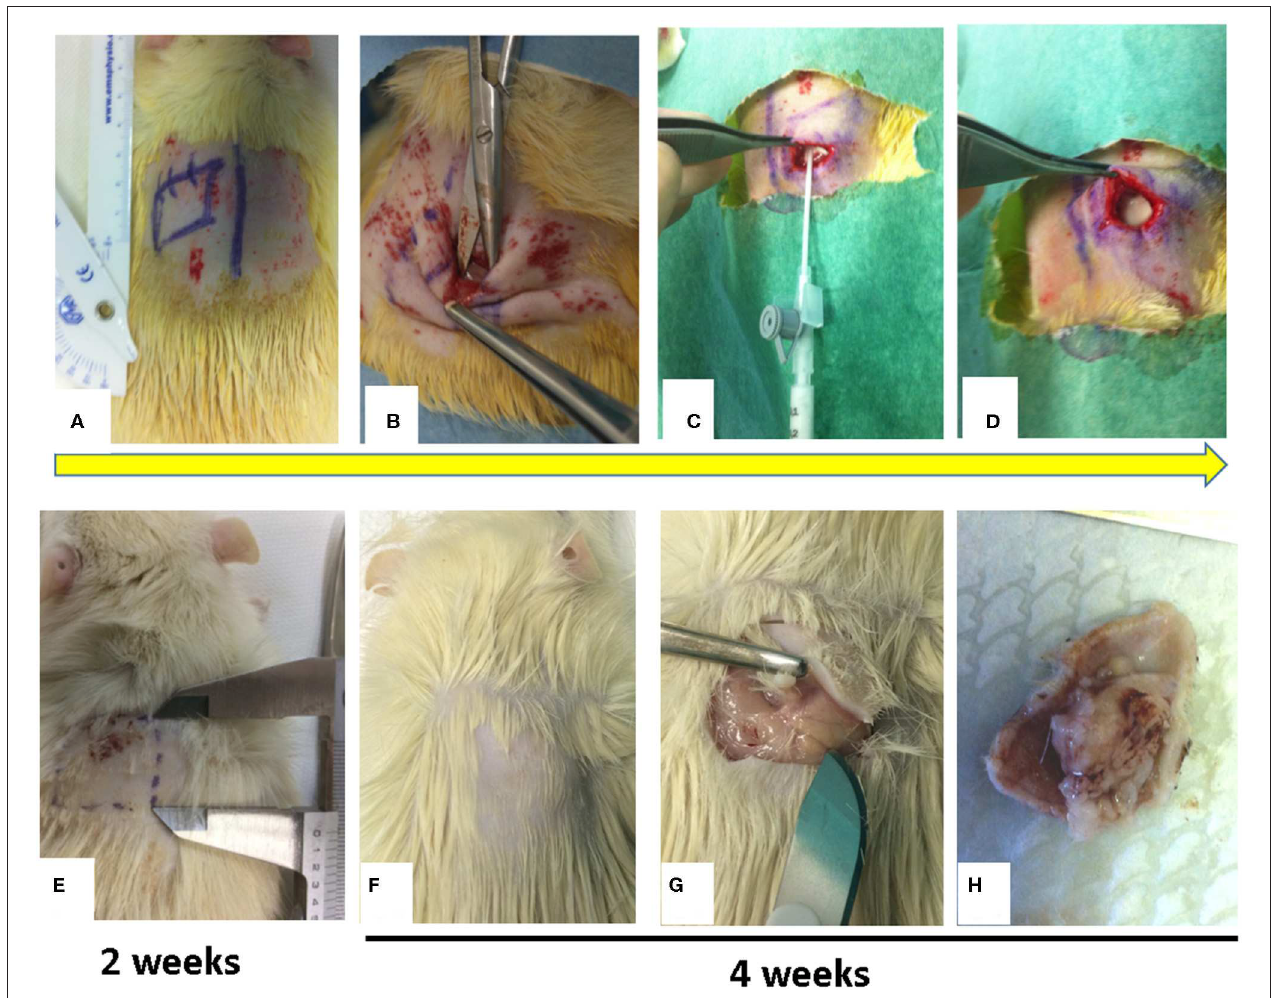
FIGURE 1 | Figure showed a sample of surgical procedure. (A) Monoliteral cutaneous incision in the dorsal paravertebral region; (B) Pocket preparation between subcutaneous connective layer and the Dorsalis Magnus muscle fascia; (C) Injection at different concentrations of talc into the pocket; (D) Skin closure of pocket to avoid talc overflow; (E) at 2 weeks, palpatory, in the injection site there is no subcutaneous granuloma formation (the rats were not sacrificed); (F–H) at 4 weeks, palpatory, in the injection site, there is subcutaneous granuloma formation and after sacrificing the rat, evidence of subcutaneous granuloma formation is observed. (SPSS Inc., Chicago, Illinois, USA) (license of the University of Padua,